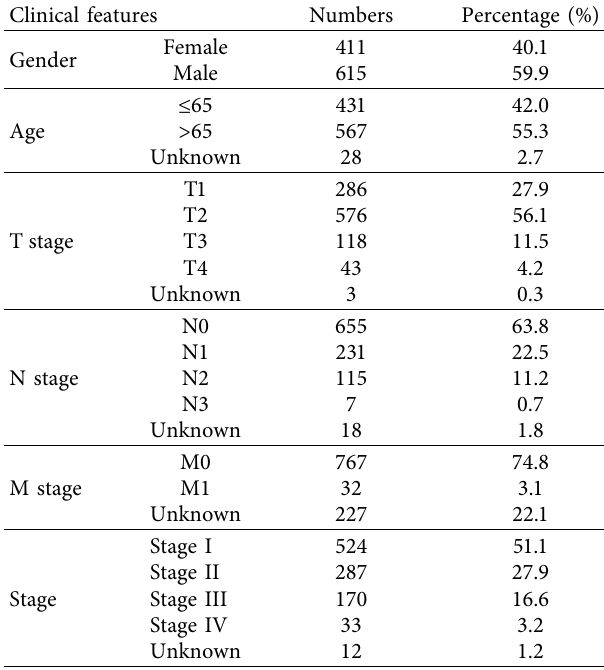
Table 1: Te baseline information of the included